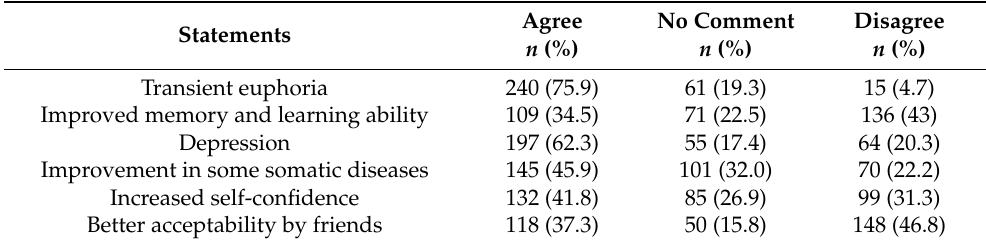
Table 3. Student perceptions about physical or psychological effects/symptoms felt after abusive drug or illicit substances.